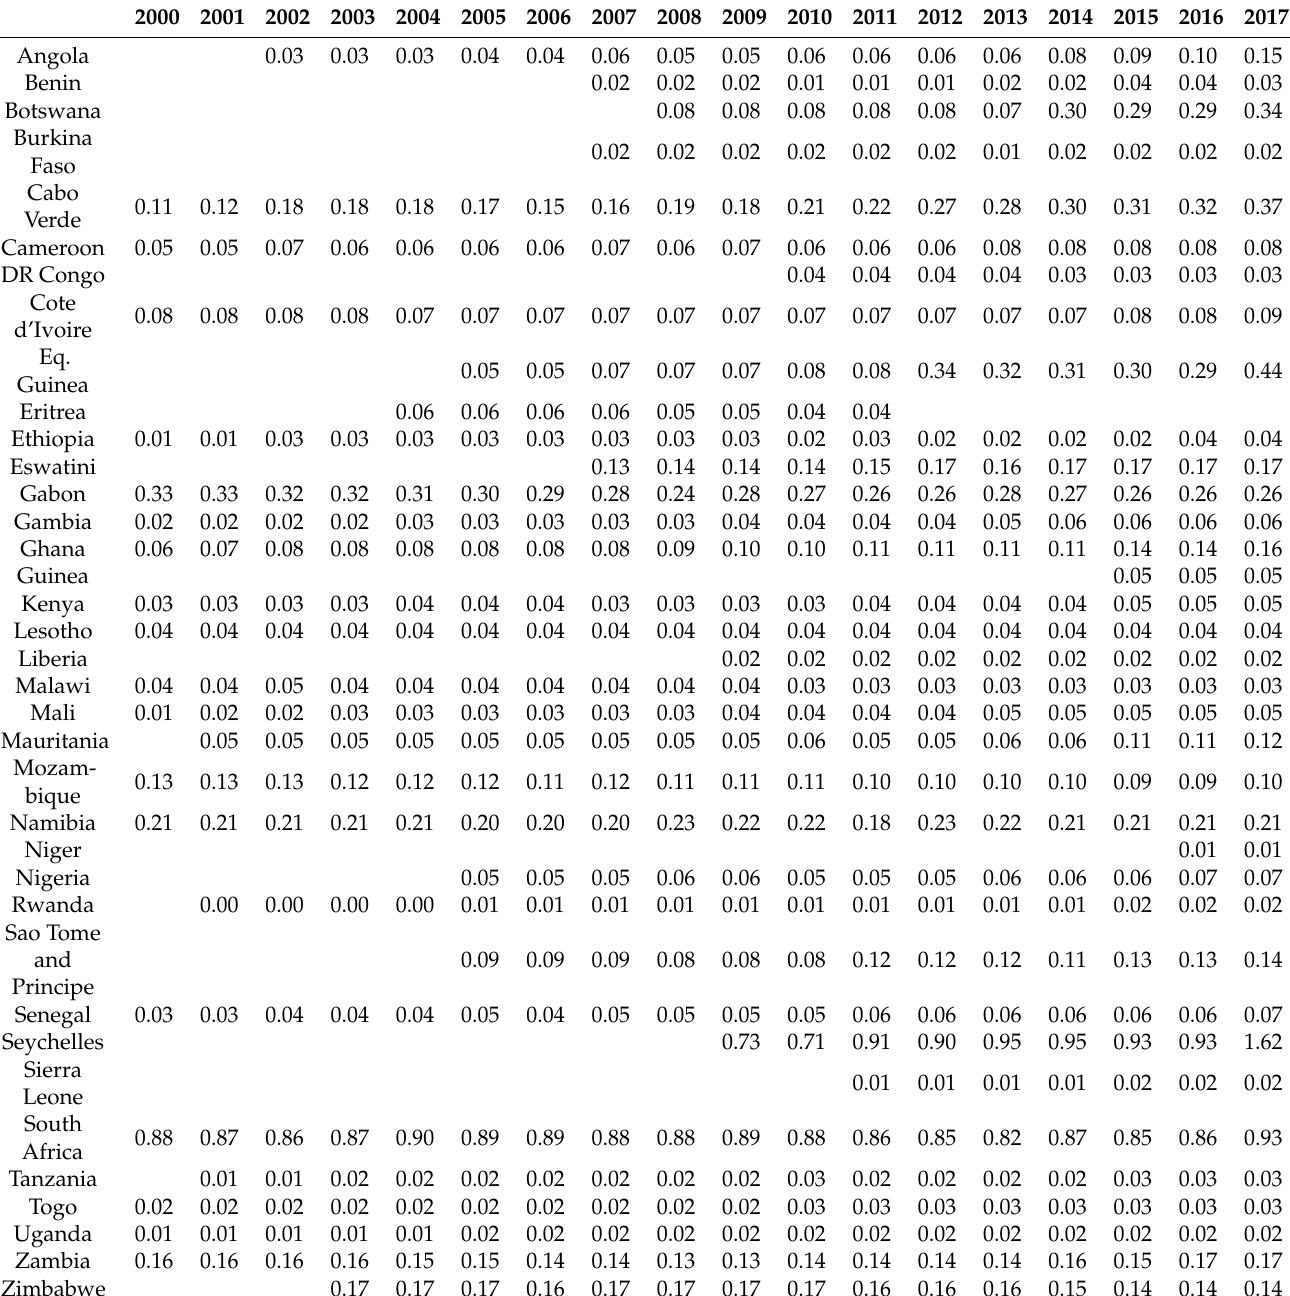
Table A2. Installed generation capacity per capita of sub-Saharan African